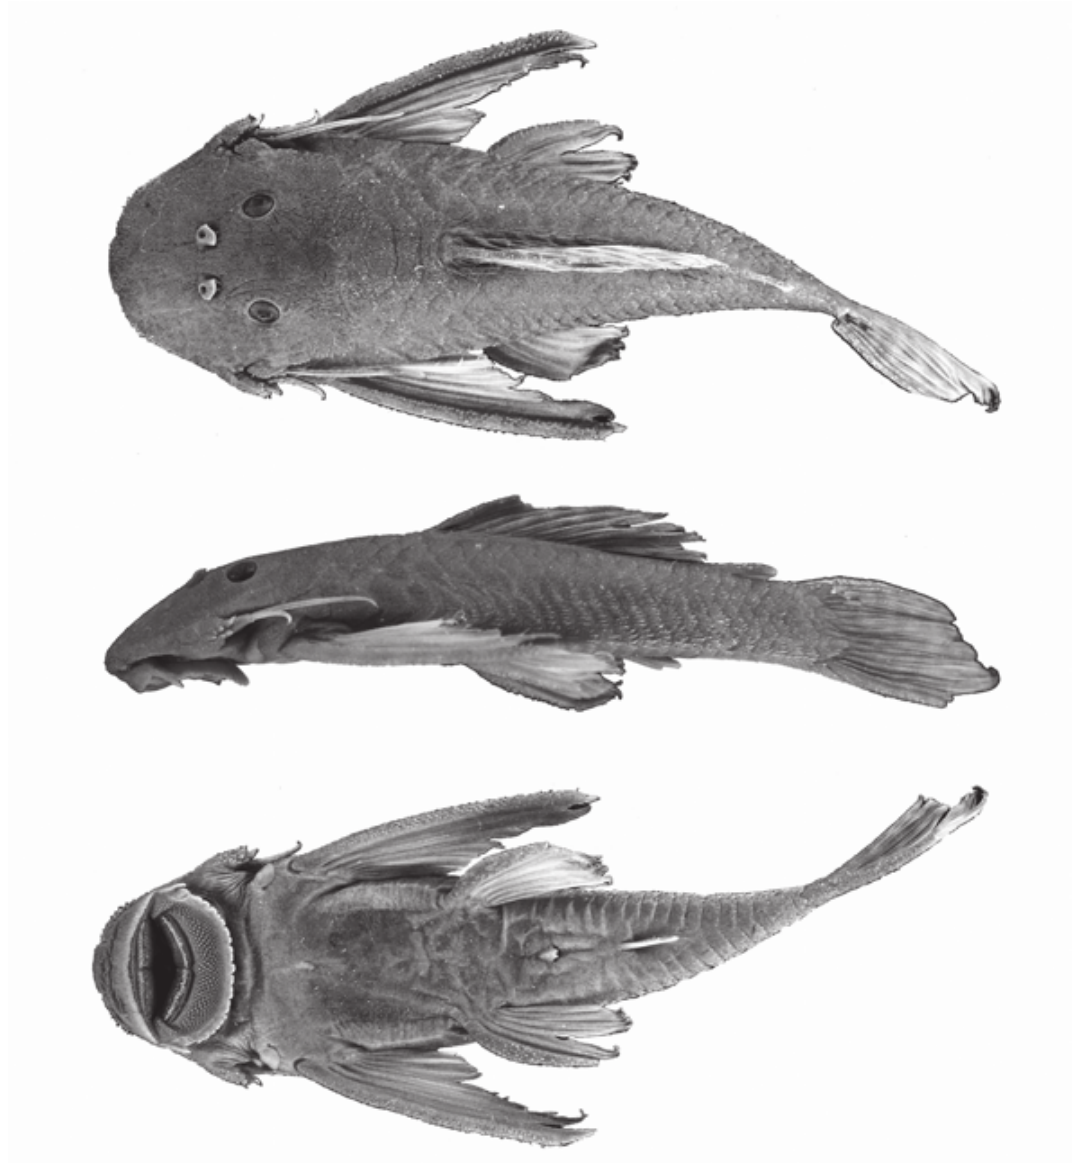
Fig. 4. Dolichancistrus cobrensis , MCNG 541, 54.1mm SL. Colombia, Departamento de Norte de Santander, El Guayabal, Cúcuta - Chinácota road; dorsal, lateral and ventral